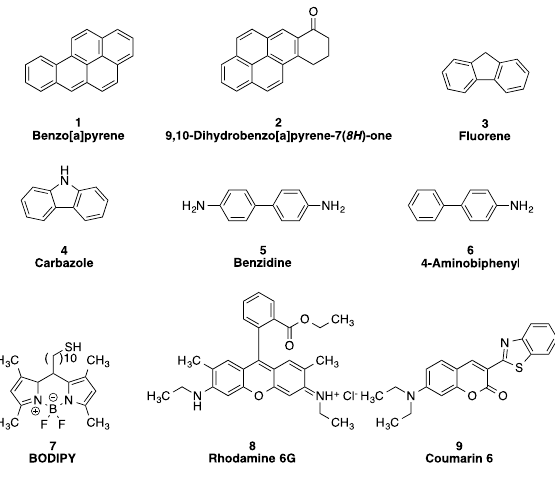
Figure 1. Structures of analytes 1 – 6 and fluorophores 7 – 9 .